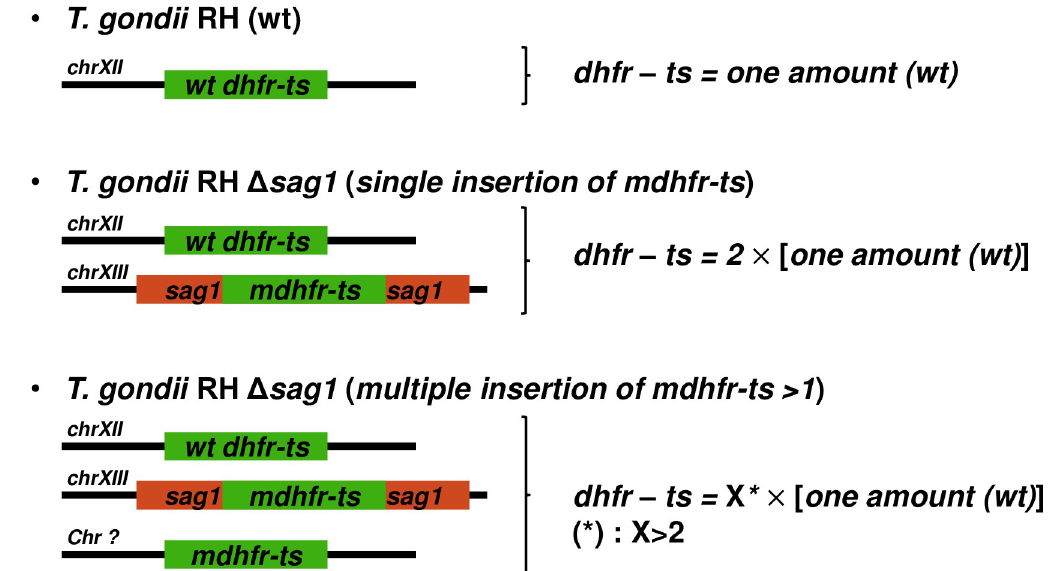
Fig 3. Principle and potential outcomes of the single